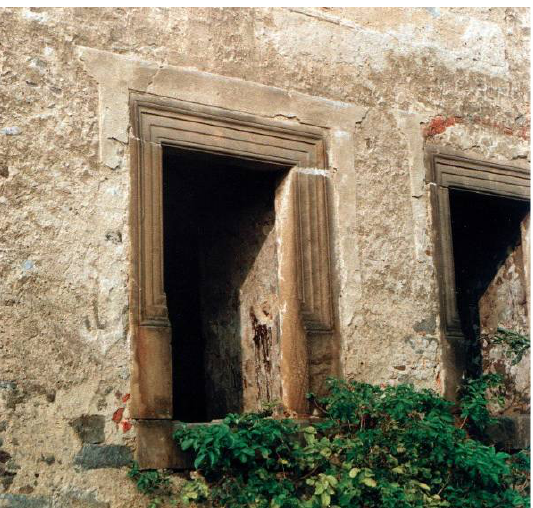
Figure 12. Window casings imitating stone detail on the facade of the manor house in